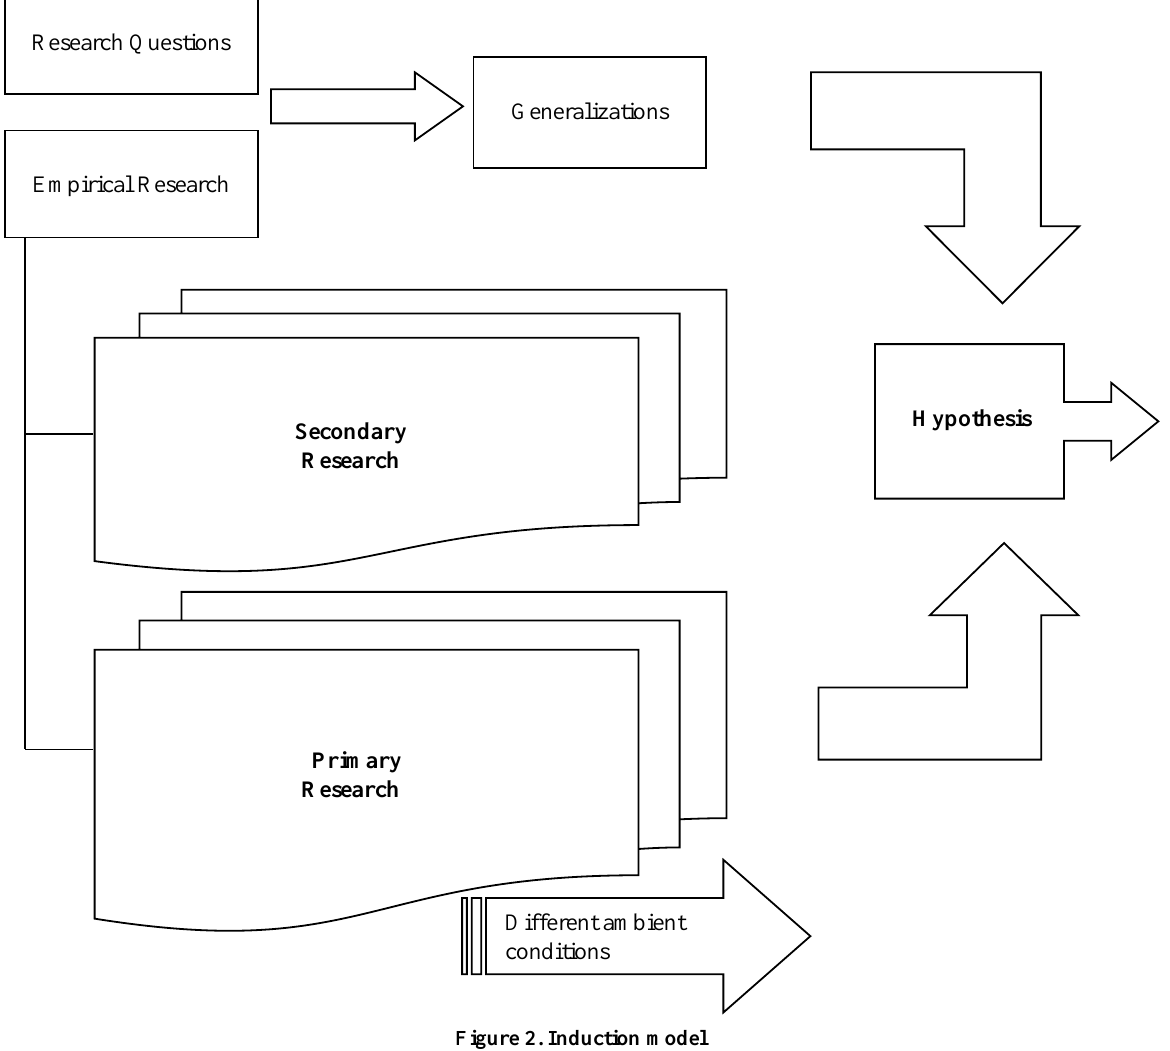
Figure 2. Induction